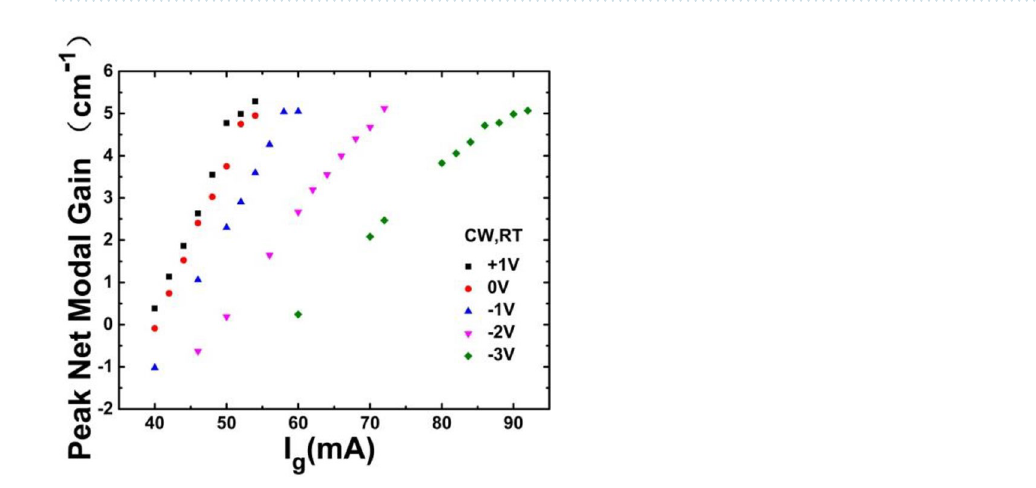
Figure 7. Net modal gain spectra of InGaAs/GaAs DQW lasers at bias V a ( a V a = 0 V; b V a = − 3 V).